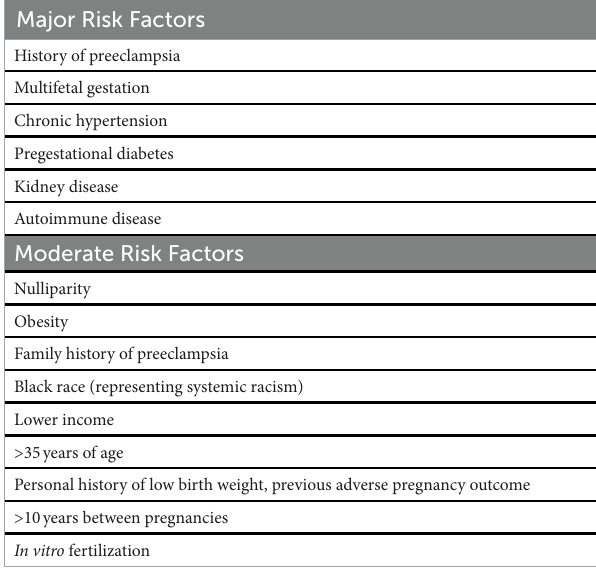
TABLE 2 Clinical risk factors and risk stratification of